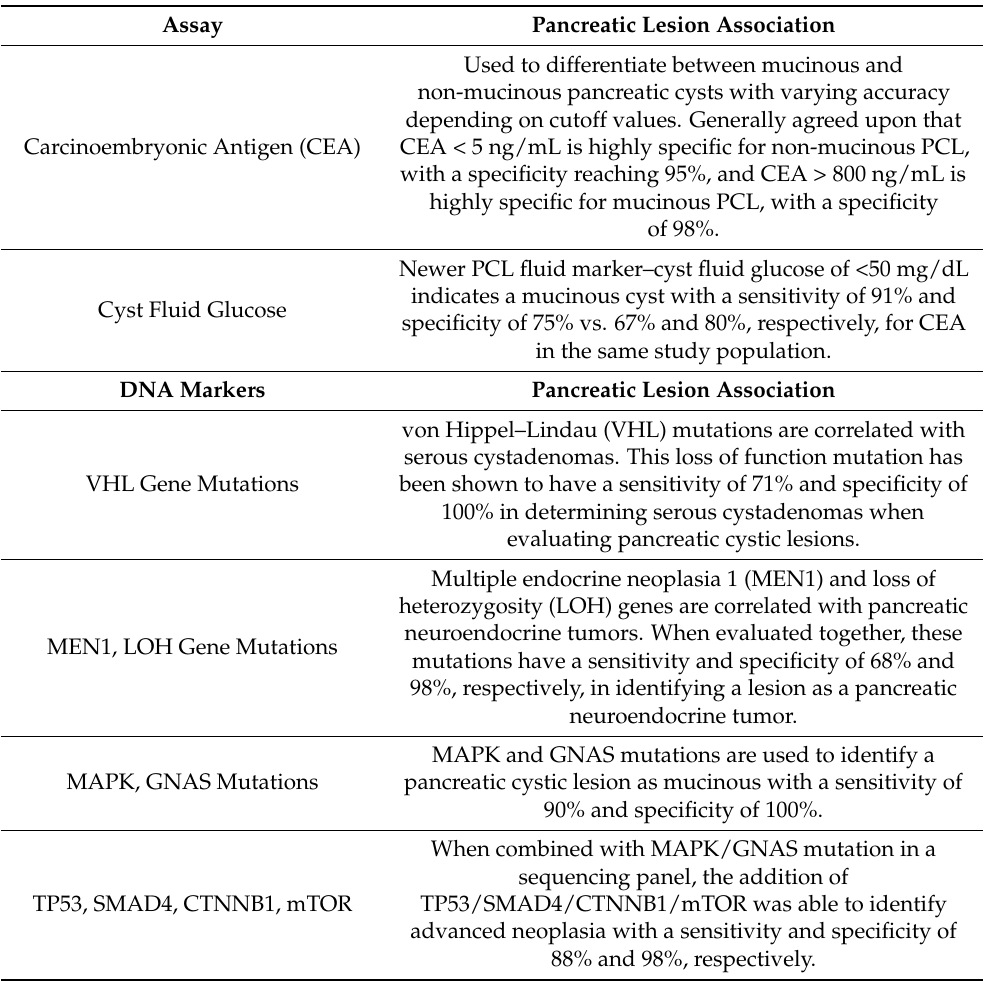
Table 2. Endoscopic Ultrasound Fluid